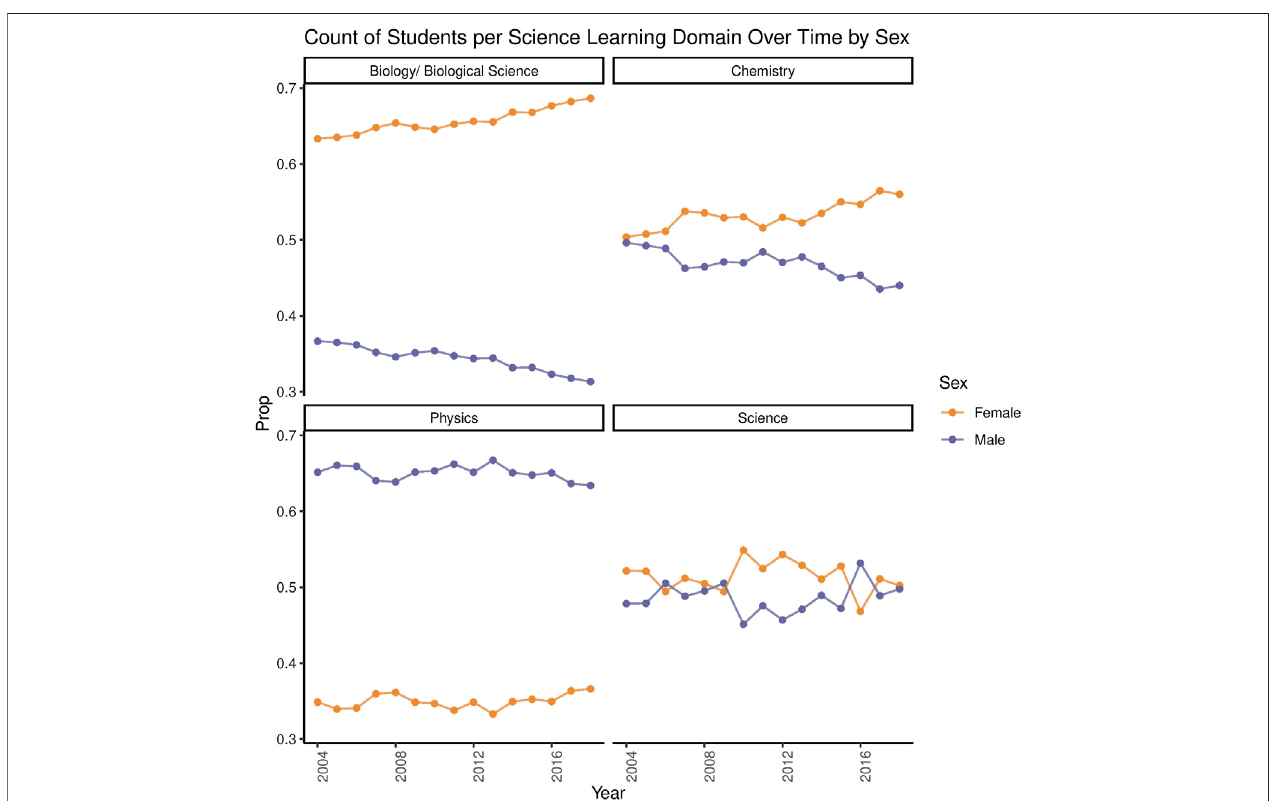
FIGURE 1 | Science Participation Rates Across Years by Sex. These plots show the participation of male and female students in key science subjects in Year 13 from 2004 to 2018. Biology and Chemistry had a greater share of female students (nearly 70% of biology students in 2018 were female). Physics continues to be male- dominated. “ Science ” represents core science assessments, which assess topics about more general aspects of science (including applications to everyday life and societal issues). This core science domain had a relatively balanced representation of male and female students across years. Data retrieved from Ministry of Education